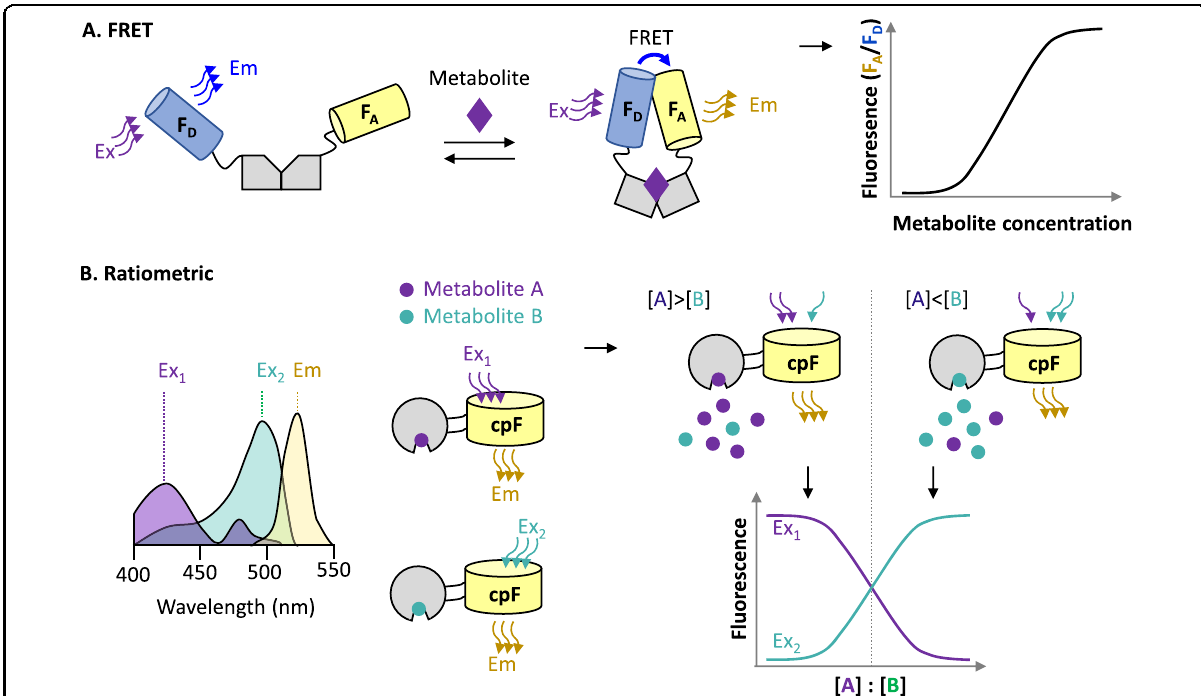
Fig. 3 Genetically encoded fl uorescent biosensors facilitate dynamic monitoring of metabolism. a (FRET) Many genetically encoded fl uorescent biosensors are based on the FRET between donor (F fl uorophores fl anking a bacterial or yeast metabolite-binding D ) and acceptor (F A ) domain. In the absence of metabolite binding, excitation of the F D results in the emission of its associated fl uorescence. However, when the metabolite binds, the biosensor undergoes a conformational change that permits FRET between fl uorophores and emission of F A fl uorescence. The F A :F D fl uorescence ratio is thus indicative of the intracellular metabolite concentration. b (Ratiometric) Circularly permutated fl uorophores associated with a metabolite-binding domain that recognizes two distinct but structurally similar metabolites can be employed for the ratiometric detection of these metabolite pairs (A & B). These fl uorophores have two distinct excitation wavelengths (Ex 1 & Ex 2 ) that stimulate fl uorescence of the same emission wavelength (Em). Occupancy of metabolite A increases the fl uorescent signal associated with Ex 1 and vice versa, so that the fl uorescence ratio of Ex 1 :Ex 2 is representative of the ratio of metabolite A: metabolite